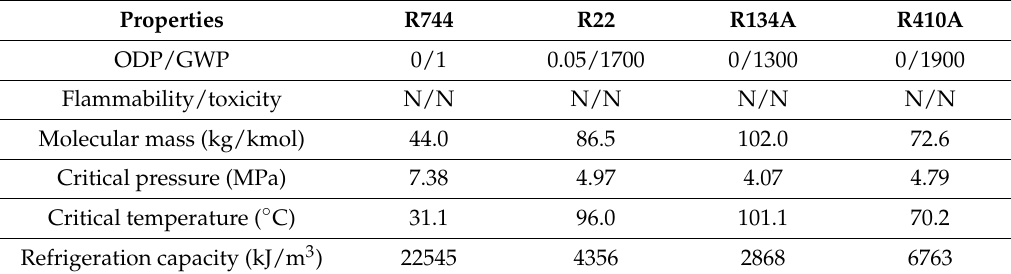
Table 1. Basic properties of CO 2 (R744) compared with other refrigerants